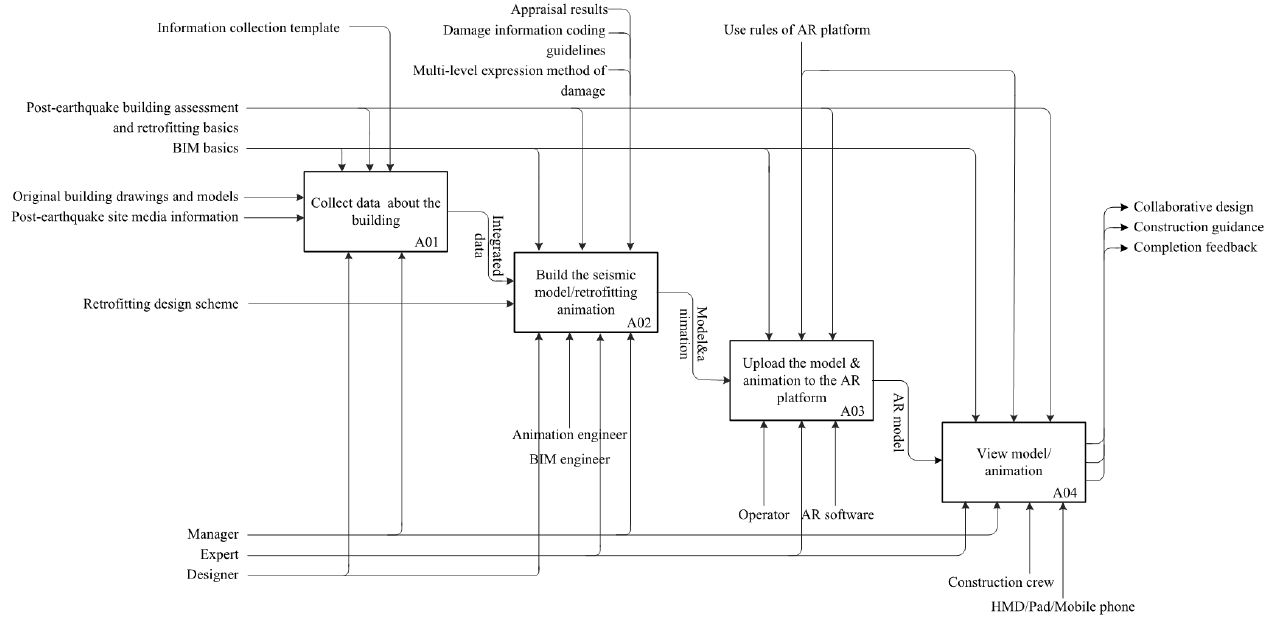
Figure 6. BIM-AR information combination